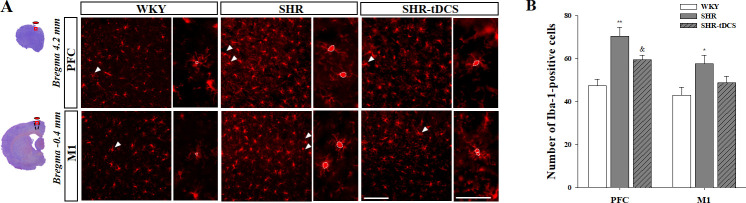
Neuroinflammatory analysis for chronic HD-tDCS application in our rat model of ADHD.(A) Photomicrograph and (B) histogram showing the mean number of Iba-1-positive cells in the prefrontal cortex (PFC) and the primary motor cortex (M1). Numbers in the PFC were significantly reduced in the SHR-tDCS group compared to those observed in the SHR group. Data are presented as the mean ± SEM. Scale bar = 100 µm.